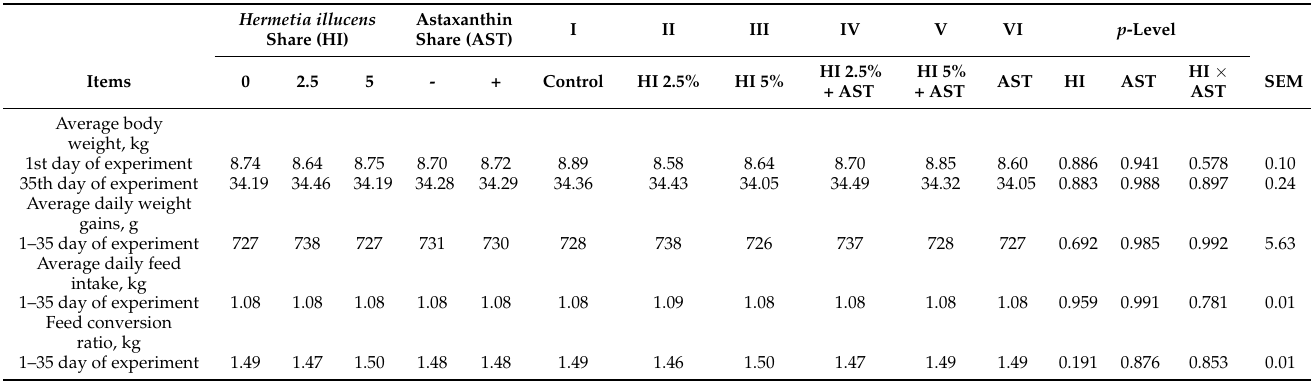
Table 2. Effect of Hermetia illucens meal share and astaxanthin presence in feed on the productivity performance of